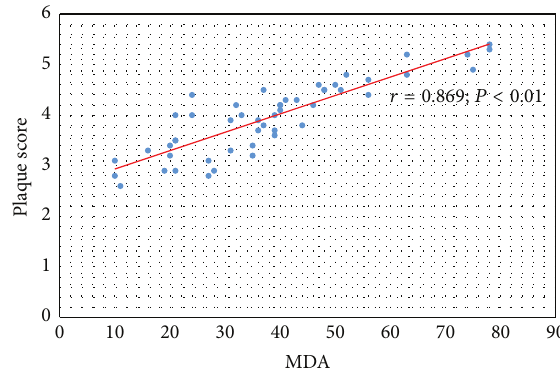
Figure 4: The relation between serum concentration of MDA and value of plaque score in CKD and PD patients.